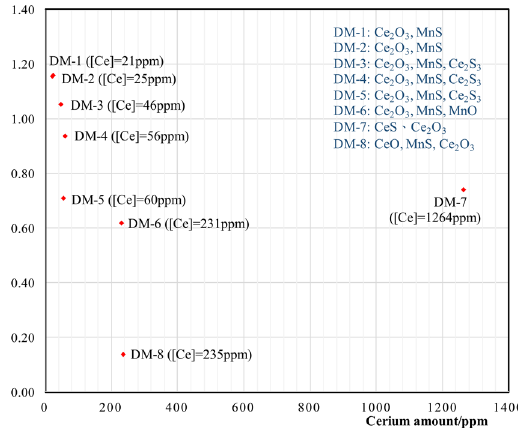
Figure 3. Inclusion species affected by amounts of cerium and oxygen to sulfur ratios in different